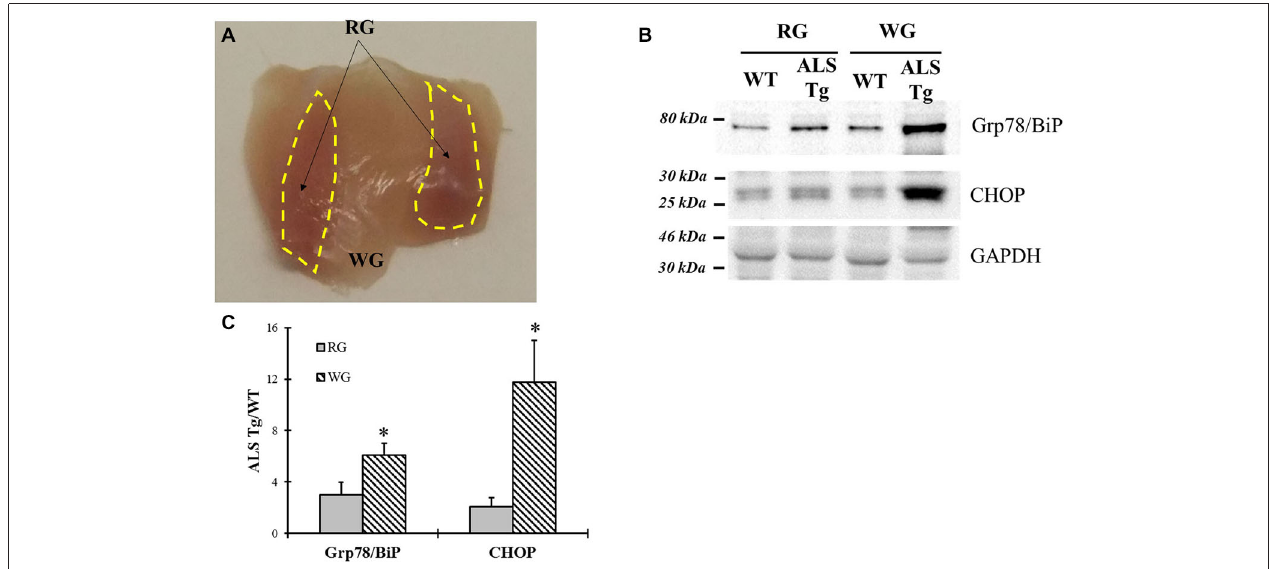
tissues of symptomatic animals (120–140d; n = 3 each for WT and ALS-Tg) were collected. Grp78/BiP and CHOP protein levels were determined using western blot technique. (C) Analysis of Grp78/BiP and CHOP average ratio of ALS-Tg to WT. Data in (B) is presented as mean ± S.E; *, p < 0.05; RG vs.